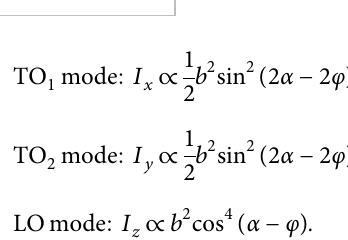
Figure 12: Raman intensity distribution under off-axis scattering ( β directions φ in the (a) HH case and (b) HV